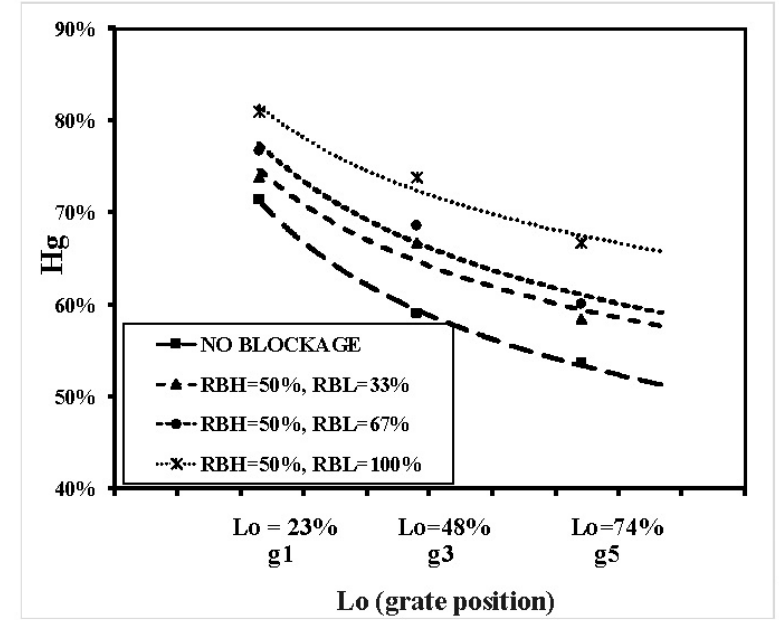
ff erent LB at HB 50% at Q = 6.00 L /